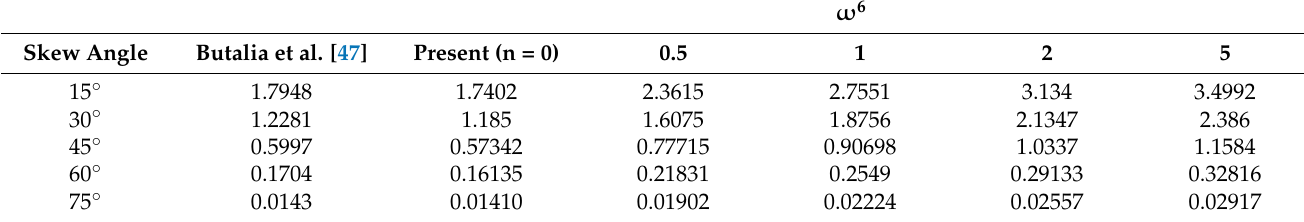
Table 10. Effect of the skewness angles on the non-dimensional central deflection (w6) of the FGM plate with clamped edges.